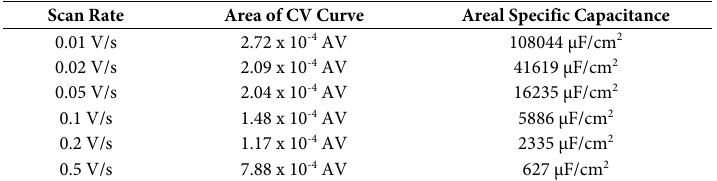
Table 1. Specific capacitance of OP-LSG coated electrode at different CV scan rates, 0.1257 cm 2 electrode area, and a 1V voltage Scan Rate